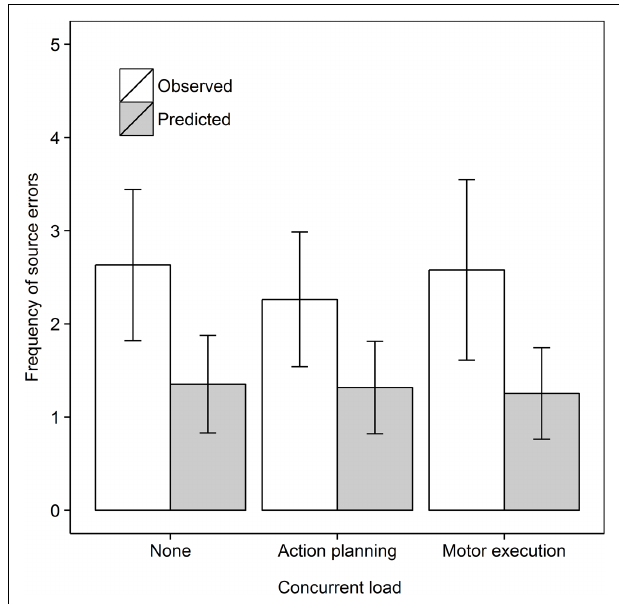
FIGURE 4 | Frequency of observed and predicted source errors in the Recall own task in Experiment 2 for all concurrent load conditions. The error bars are 95% within-subjects confidence